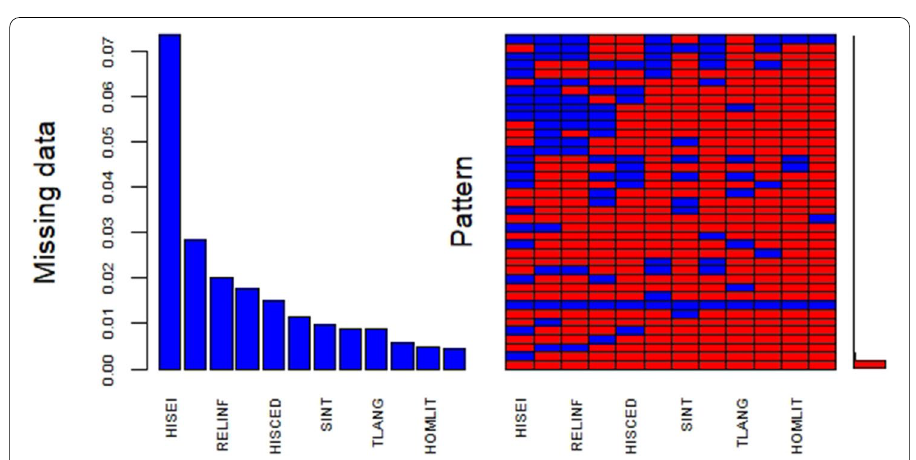
Fig. 7 Structure (pattern) and percentage of missing